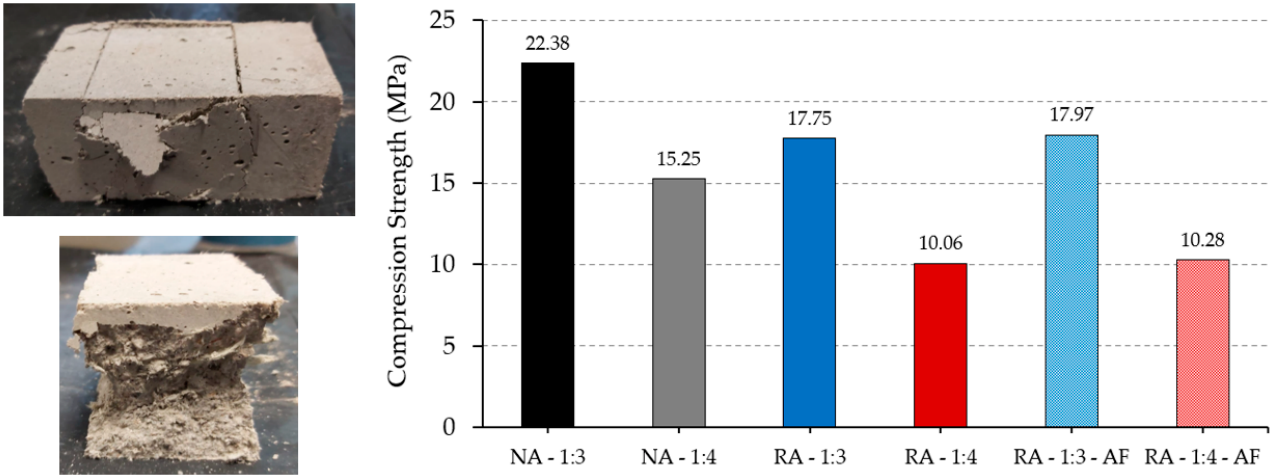
Figure 4. Results of the compressive strength test image of specimen RA ‐ 1:3 ‐ AF type tested.